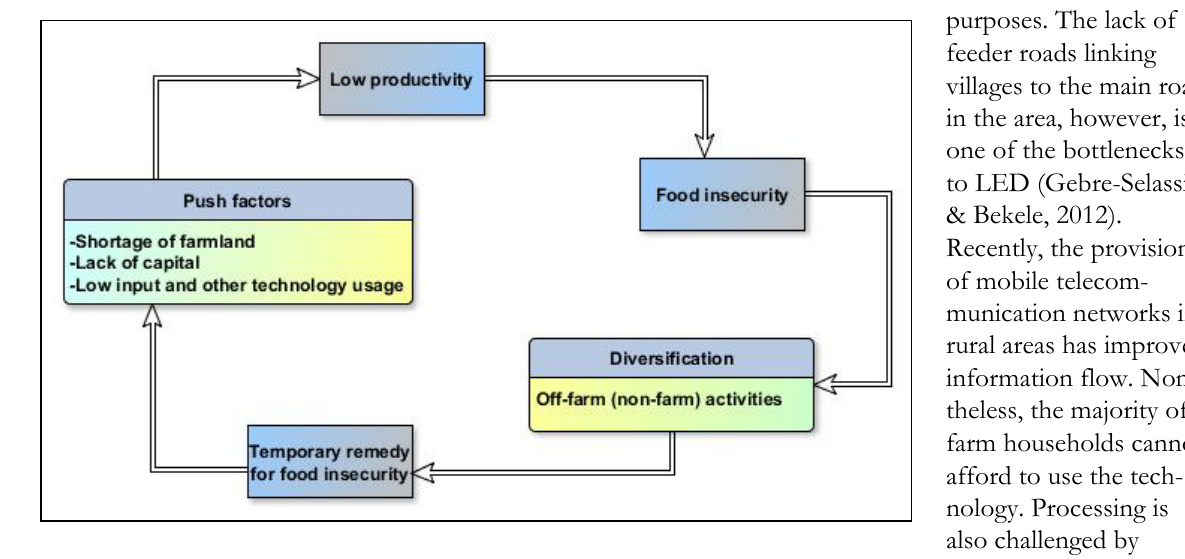
Figure 1. The “Survival Strategy” of Rural-urban Linkages and Local Economic Development (LED) in Guto Gidda